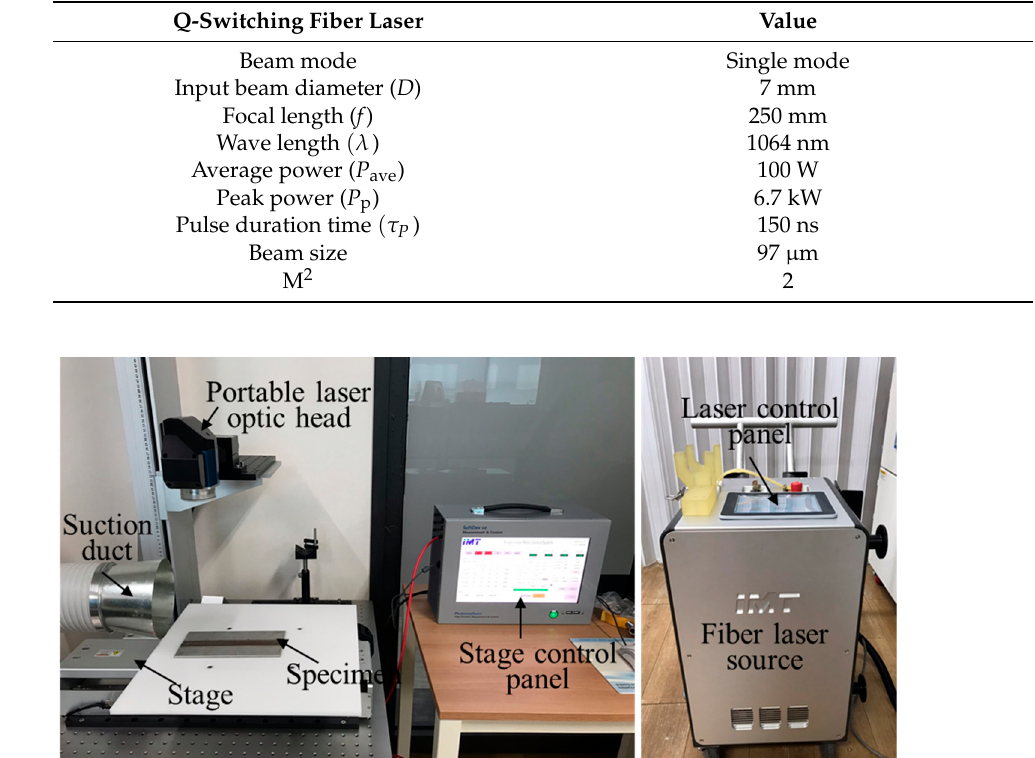
Table 2. Specification of laser cleaning equipment.